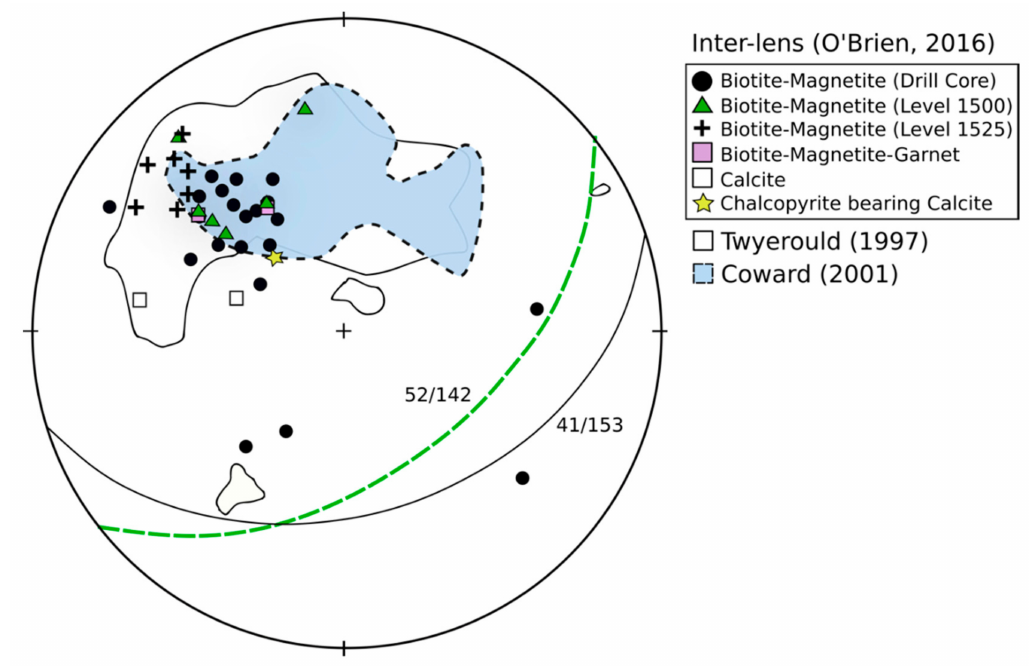
Figure 7. Poles to S 2 mineral foliations measured in the Inter-lens on level 1500 (green triangles) and 1525 (crosses) from O’Brien [36]. The green dotted great circle represents the average foliation on level 1500, the solid black great circle represents the average foliation on level 1525. Measurements of magnetite-biotite foliation (black dots); biotite-magnetite-garnet foliation (pink squares), calcite veins (unfilled squares), and a chalcopyrite-bearing calcite vein (yellow star) from orientated drill-core that intersects the Inter-lens [35]. The clear solid outline represents the extent of S 2 foliation measurements in the HWSZ and FWSZ recorded by Twyerould [1]. Areas within the blue dotted outline